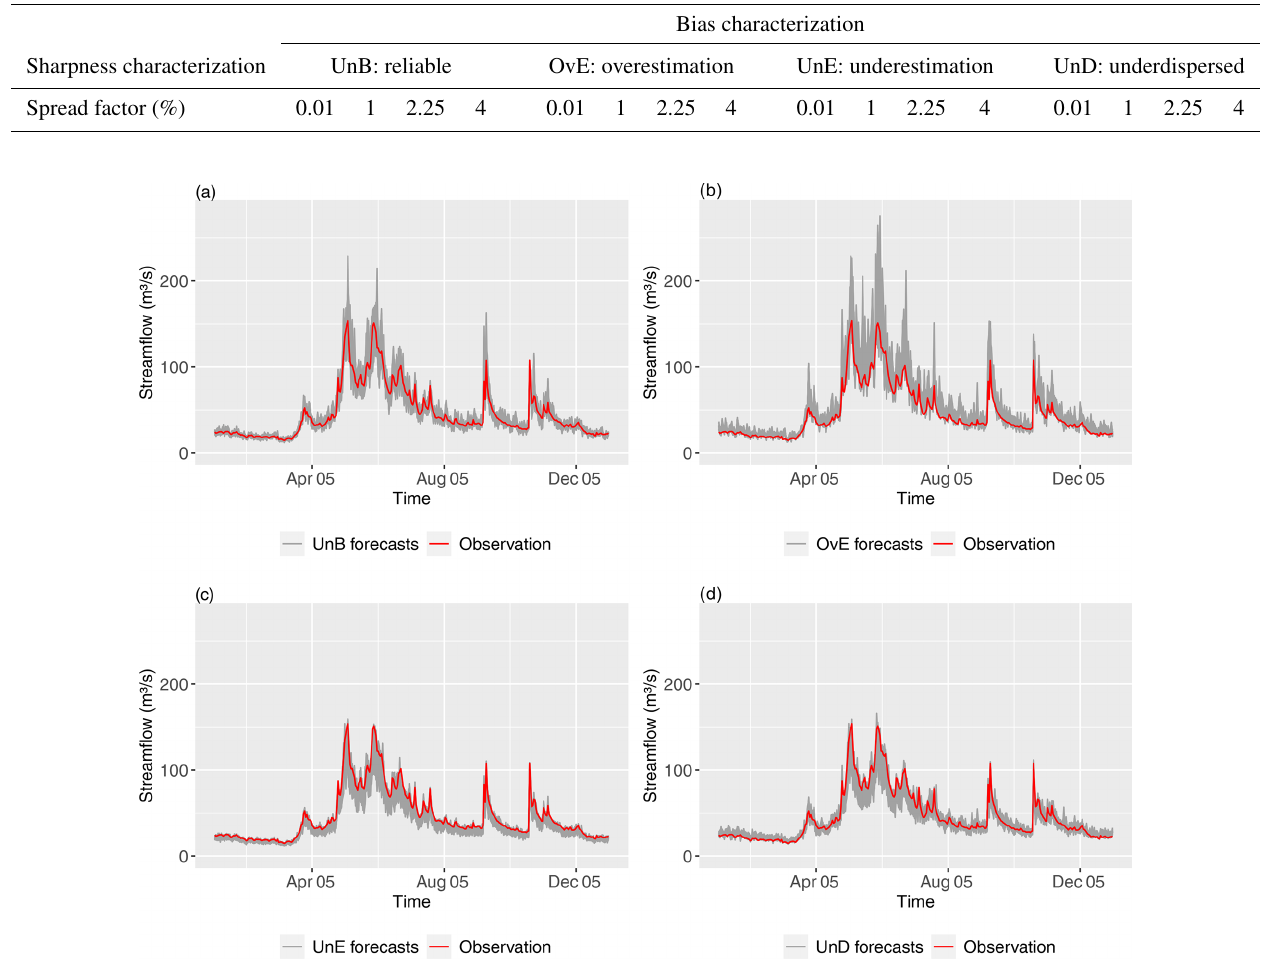
Table 1. Summary of the 16 synthetic forecasting systems generated according to the four bias characterizations (UnB, OvE, UnE and UnD) and the four sharpness characterizations (spread factors) applied.